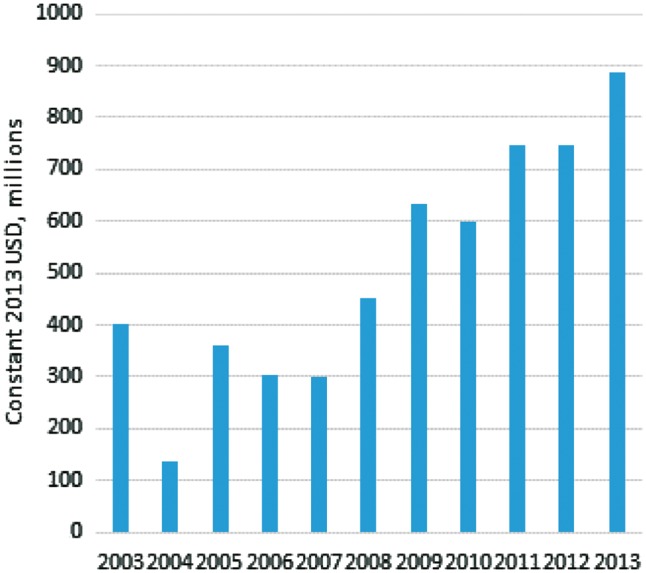
Total ODA+ disbursements for family planning